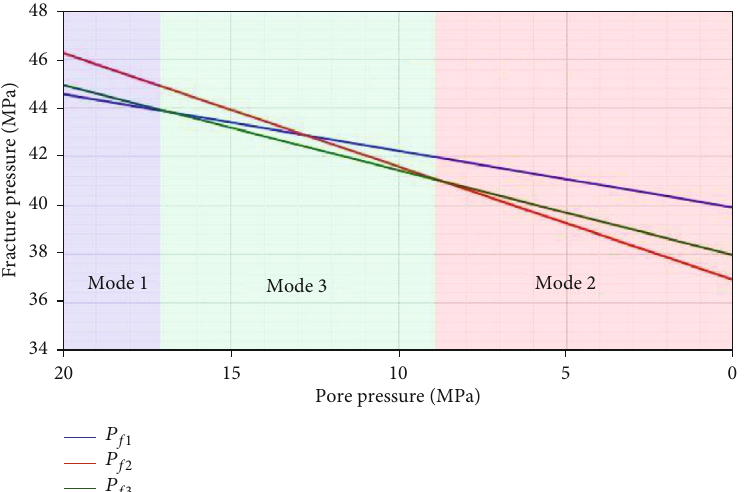
Figure 2: Change of fracture mode and fracture pressure with reservoir depletion of vertical wellbore drilled in normal fault stress